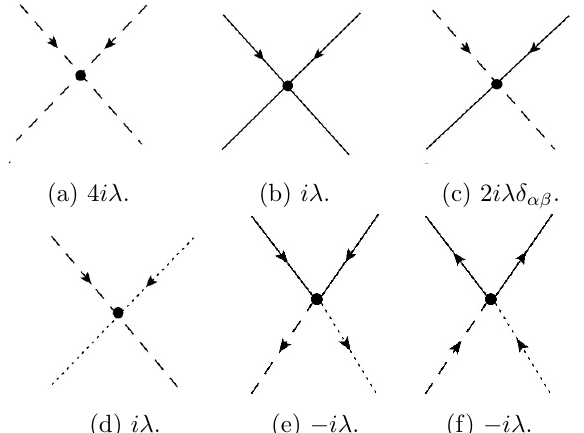
Figure 5. Feynman rules for the interaction in (4.8). The vertex in (cid:12)gure 5b corresponds to the four